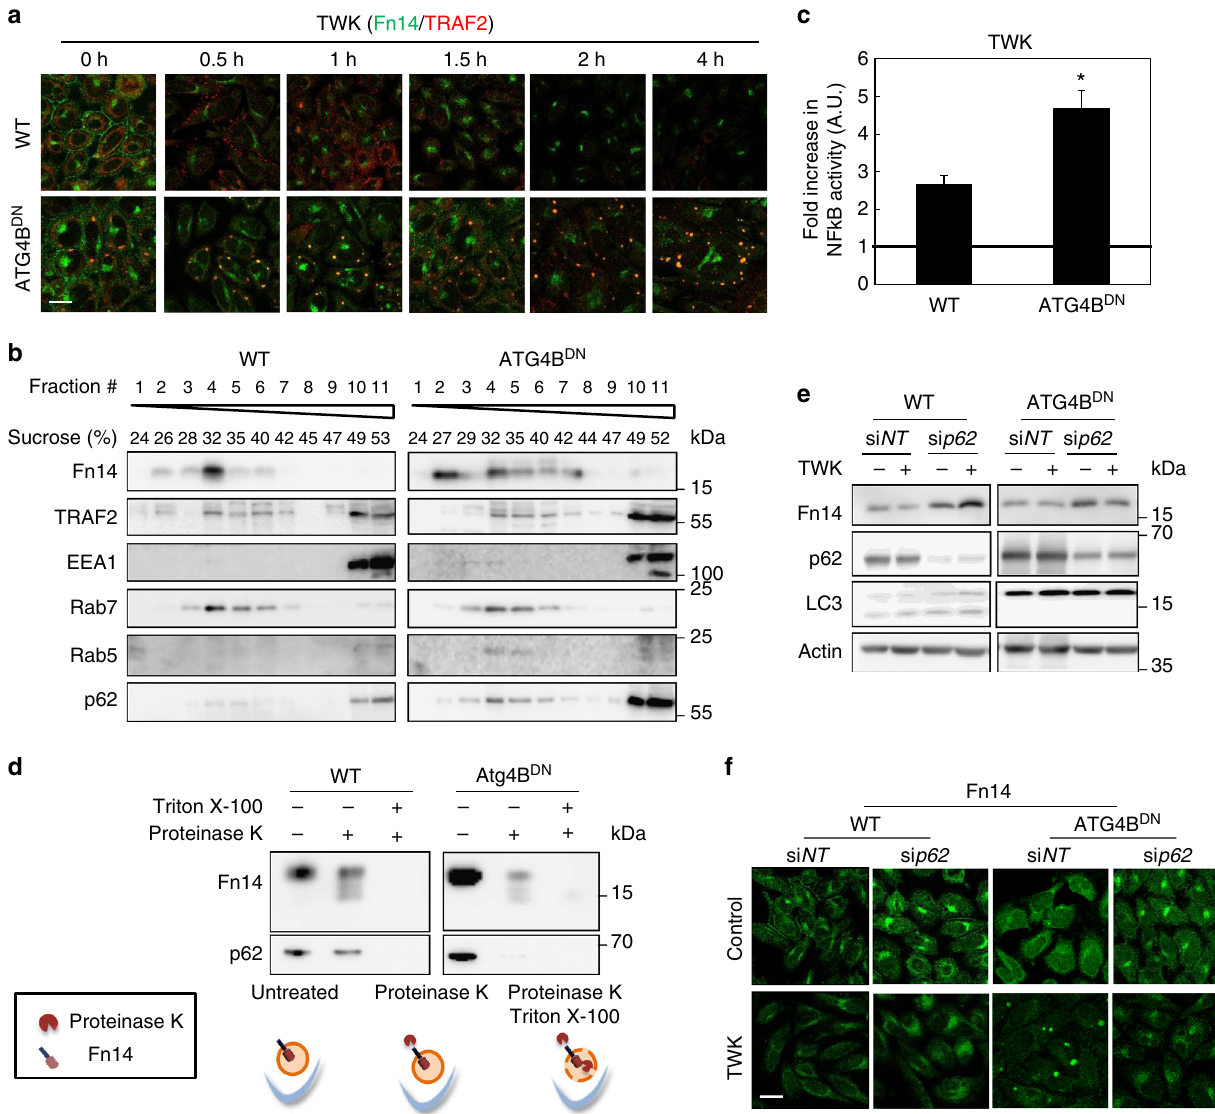
Fig. 4 Fn14-positive vesicles accumulate in a TWEAK-dependent manner upon Atg8s inactivation by dominant-negative ATG4B. a – f WT or ATG4B DN stable expression HeLa cells were assayed as follows: a treated with TWK for indicated times, immunostained for Fn14 and TRAF2, and analyzed by confocal microscopy (scale bar, 20 µ m); b treated with TWK and subjected to membrane fl oatation assay as detailed under Methods; c transfected with luciferase expression constructs as detailed under Methods, treated with TWK as indicated, and further subjected to luciferase assay as detailed to assess NF-kB activity (* P < 0.05, n = 3 biological repeats; comparisons by T test; mean ± s.e.m.). The vertical line represents control in the absence of TWK; d subjected to Proteinase protection assay (upper panel) as detailed under Methods and schematically depicted (lower panel). e , f transfected with si NT or siRNA against p62 (si p62 ) and treated with TWK, extracted proteins were immunoblotted ( e ) or cells were immunostained for Fn14 and analyzed by confocal microscopy (scale bar, 20 µ m) ( f